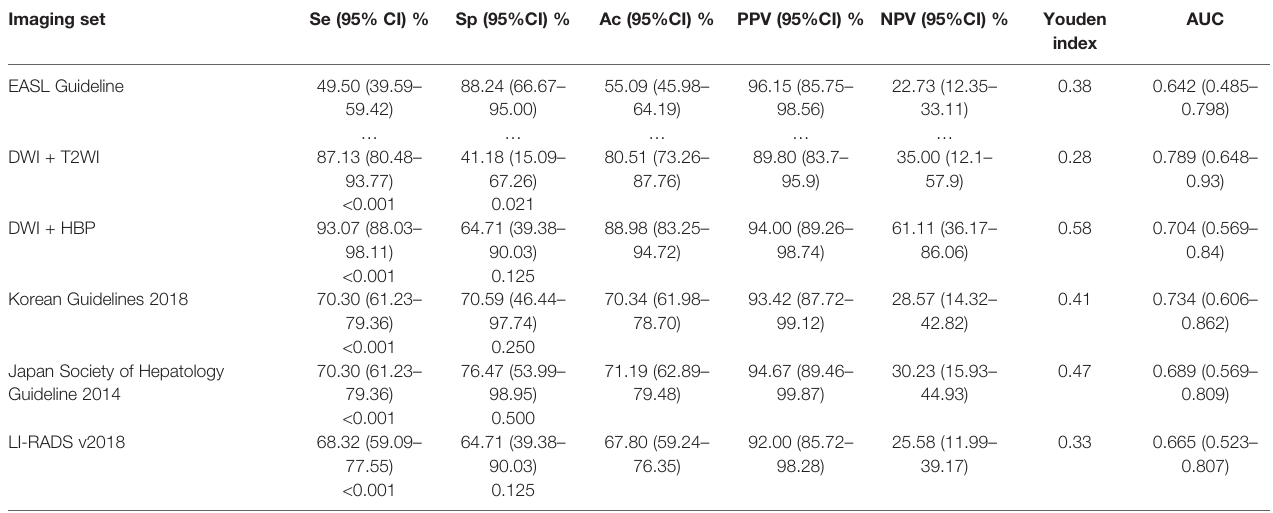
TABLE 2 | Diagnostic performance of these criteria using HBSC-MRI. Imaging set